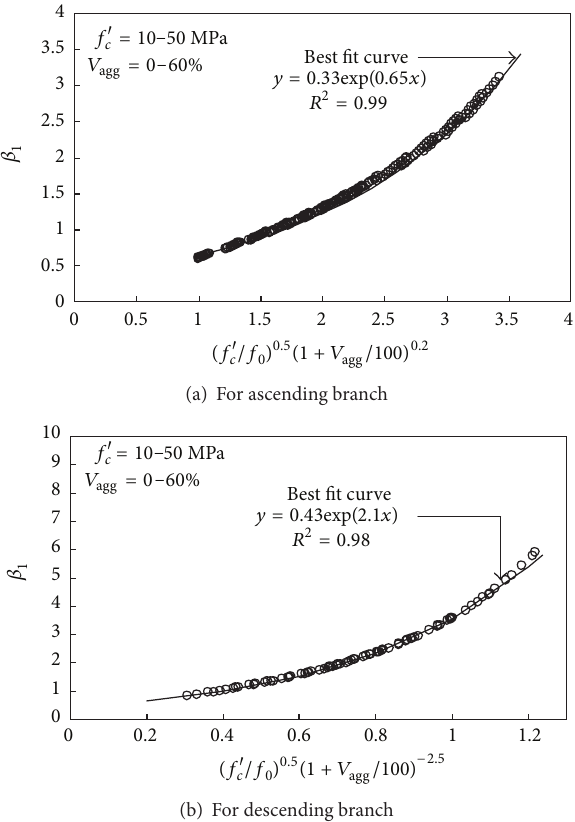
∗ 𝛾 𝑒,𝑚 and 𝛾 𝑒,𝑠 refer to the mean and standard deviation, respectively, of the NRMSE calculated for each specimen using the following equation: